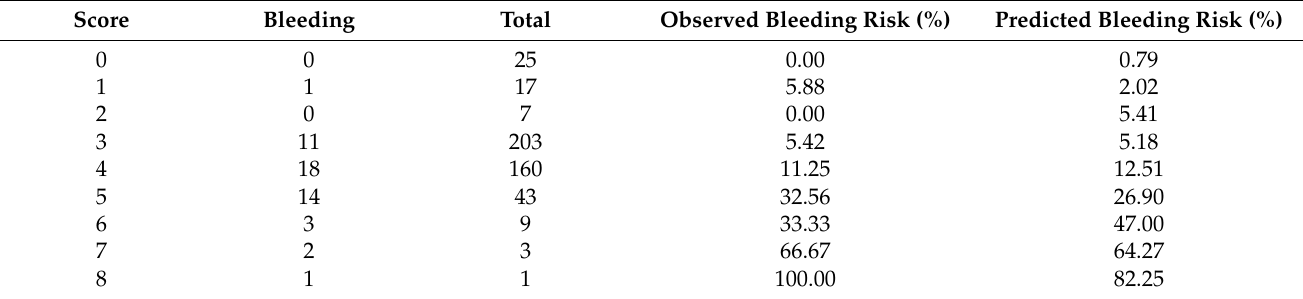
Figure 3. The logistic regression curve of the probability of bleeding versus the proposed scoring scale. Table 5. The observed and predicted bleeding risk (%) by risk score.